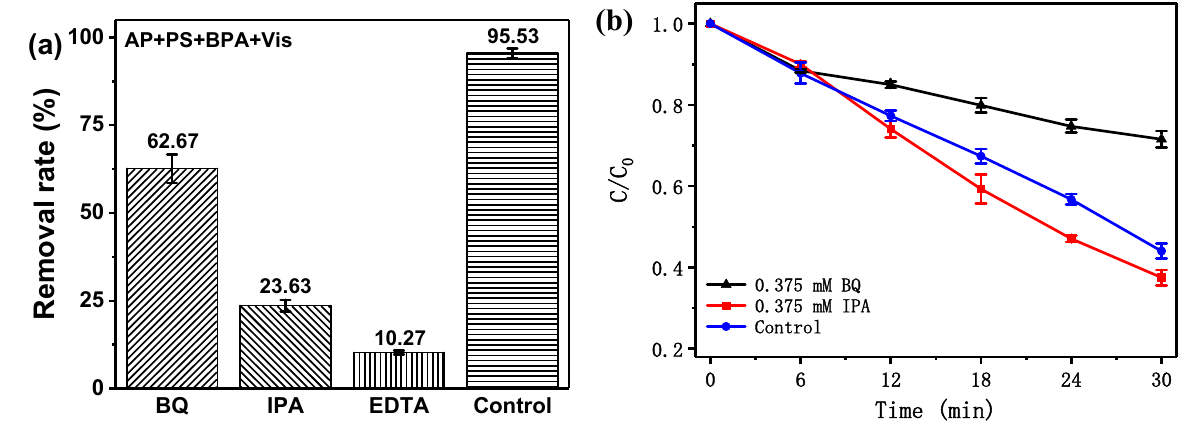
Figure 12. ( a ) Effect of different radical scavengers on removal rate of bisphenol A with Ag 3 PO 4 and potassium persulfate as catalysts under visible light irradiation; ( b ) effect of different radical scavengers such as benzoquinone and isopropanol on removal efficiency of bisphenol A with Ag 3 PO 4 and potassium persulfate as catalysts under visible light irradiation.